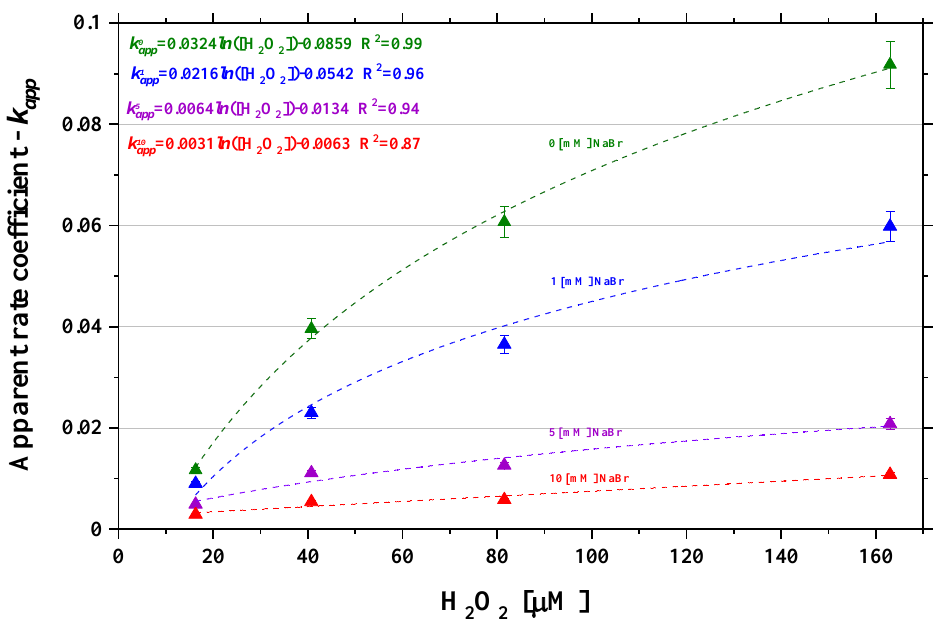
Figure 5. Apparent rate coefficients ( k app ) as a function of H 2 O 2 concentrations, in the presence of different NaBr concentrations in mM (10, 5, 1, and 0 represented by the different colors: red, purple, blue and green respectively). Dashed plots represent a logarithmic regression fitting as described by the equations.